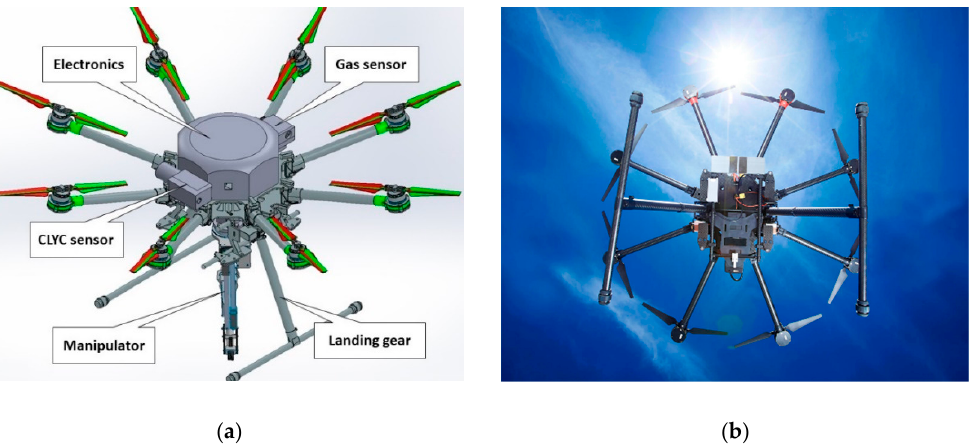
Figure 1. ( a ) Rendering of the unmanned aerial system (UAS) with attached payload; ( b ) aerial robotic platform in